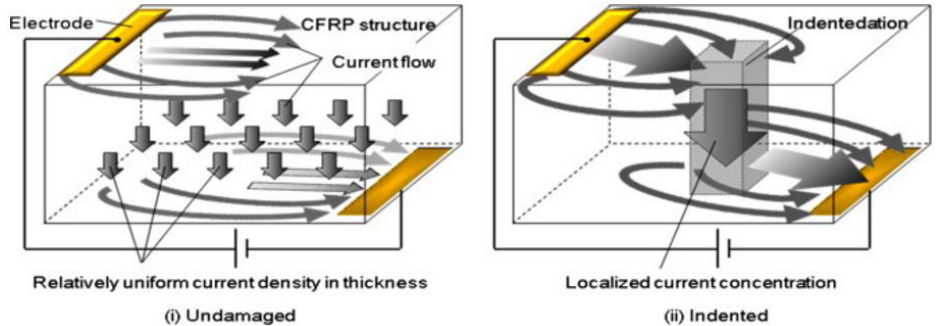
Figure 21. Schematic of the technique developed by Suzuki et al.: difference in the path of the electrical current in the case of undamaged and indented areas, with permission from 148.